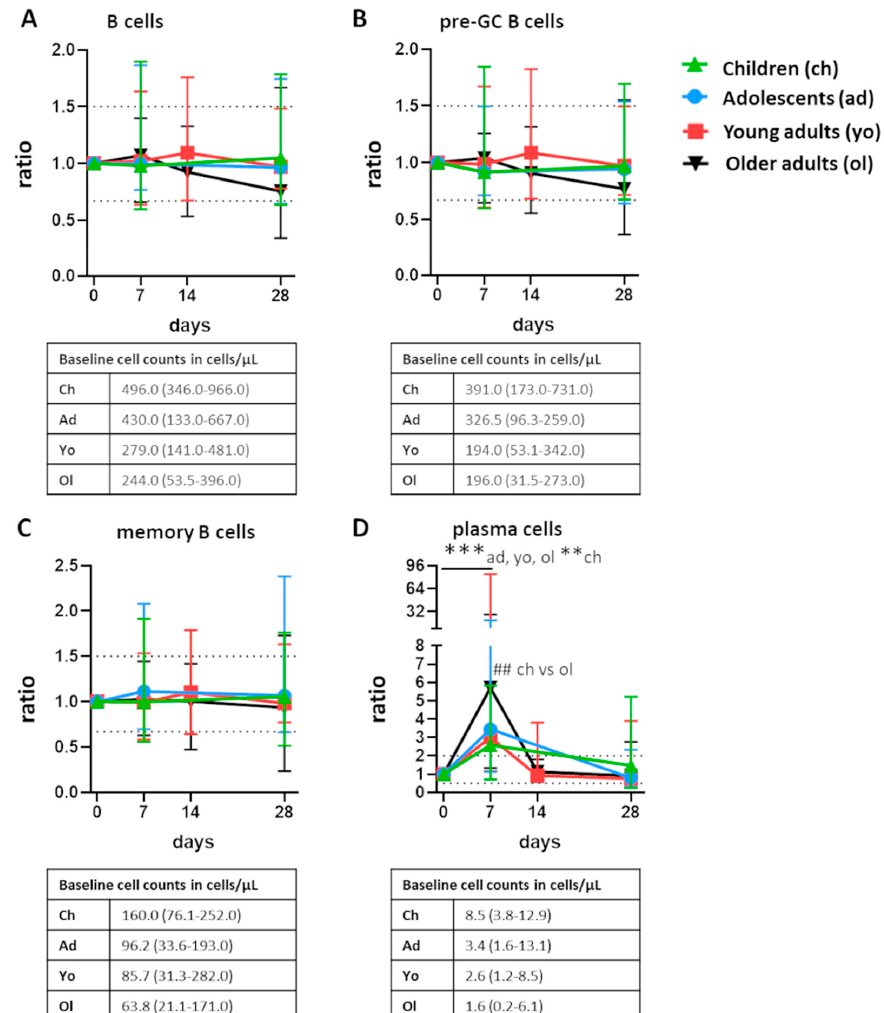
Figure 1. Postvaccination fluctuations of major B-cell subsets. Fluctuations of ( A ) total B cells ( B ) pre-germinal center (pre-GC) B cells, ( C ) memory B cells, and ( D ) plasma cells postvaccination presented as ratio over baseline (median, min-max). For total B cells, pre-GC B cells, and memory B cells, the dashed lines indicate a ratio over baseline of 0.67 and 1.5. For plasma cells, the dashed lines indicate a ratio over baseline of 0.5 and 2.0. Underneath each graph, the baseline cell counts per cohort are presented in cells/ μ L (median, min-max). To assess longitudinal changes within each cohort, Wilcoxon matched pair signed-rank test followed by Bonferroni correction was used. To test differences between cohorts at one timepoint, Kruskal–Wallis followed by Dunn’s test was used, with exception of the comparison at day 14. At day 14, only blood samples from the adult cohorts were collected; here, the Mann–Whitney test followed by Bonferroni correction was used. For longitudinal changes, only significant differences compared with baseline are shown. Significant longitudinal differences within a cohort are indicated as **, p ≤ 0.01; ***, p ≤ 0.001. Significant differences between cohorts at the same time point are indicated as ##, p ≤ 0.01.